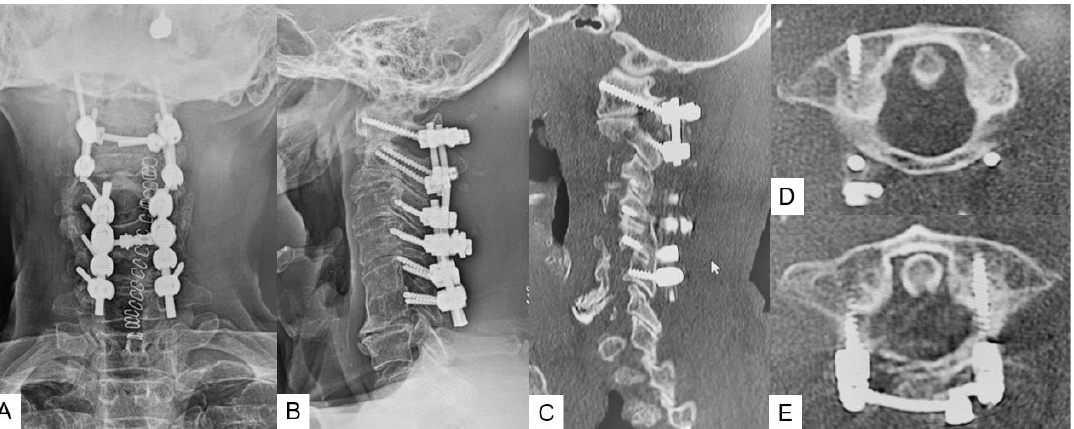
Figure 3. Postoperative images, ( A ): anteroposterior radiogram, ( B ): lateral radiogram, ( C – E ) CT, C: C1 LMS (mid-point), ( D , E ): C1 axial view.